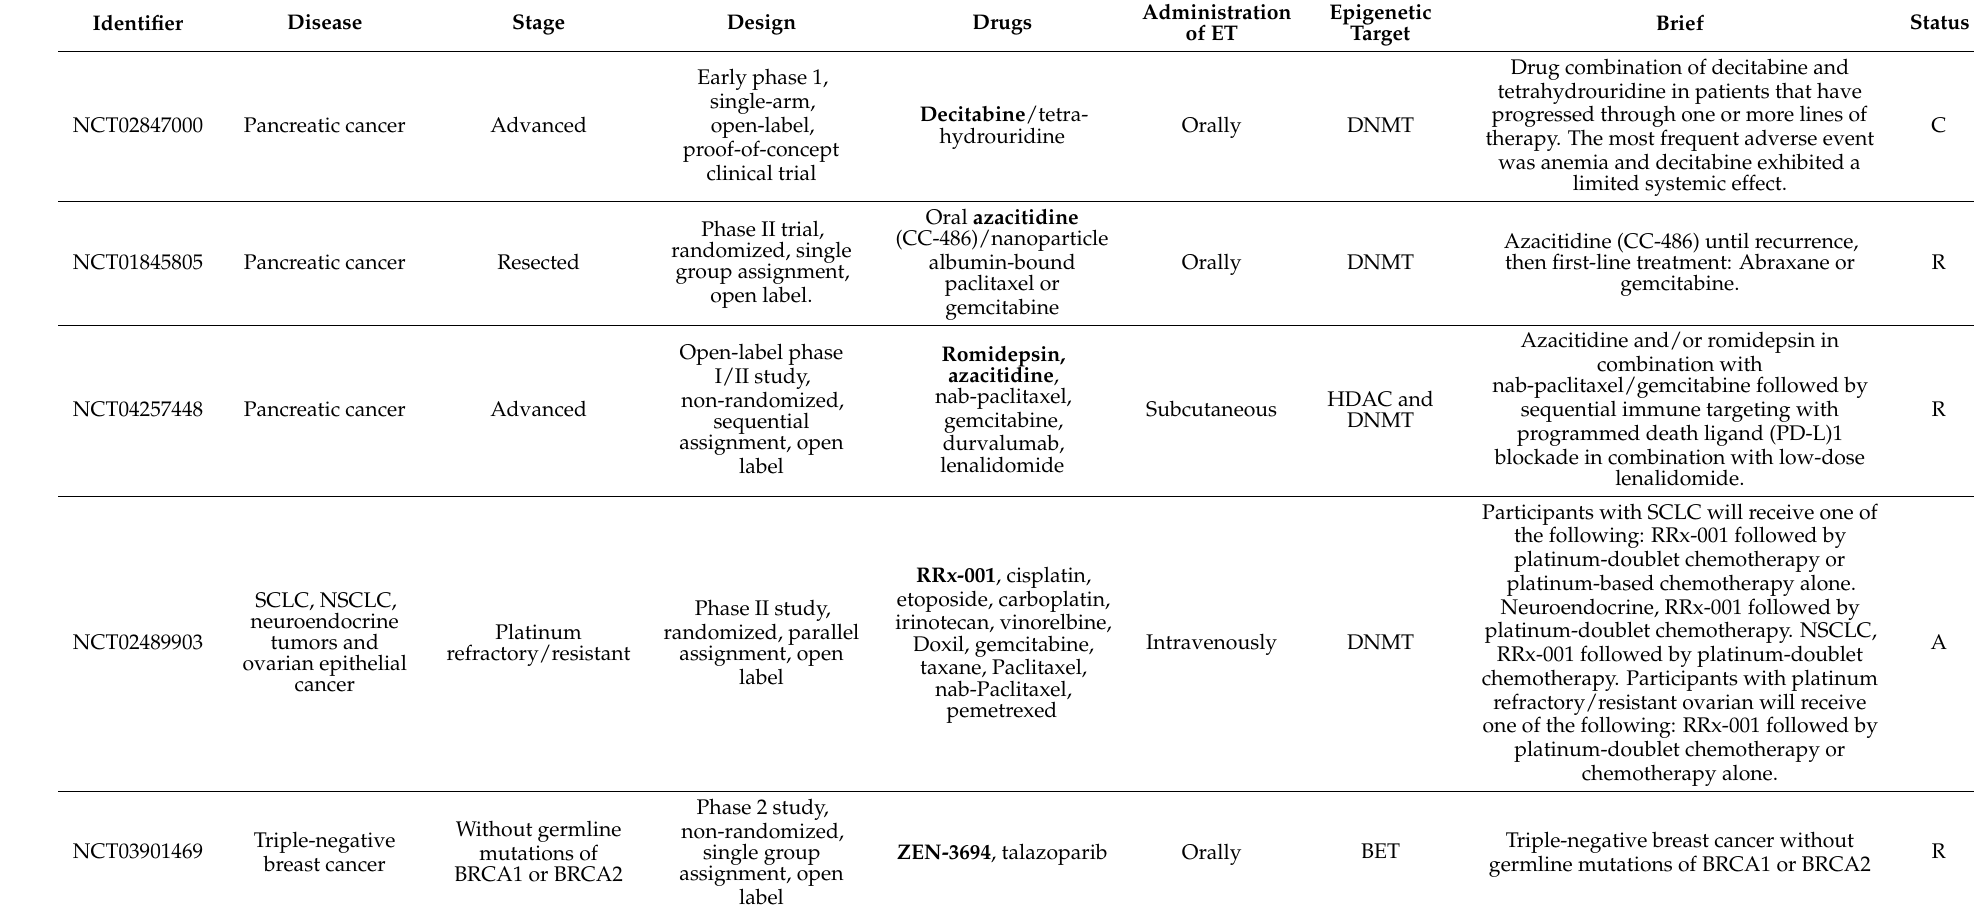
Table 1. Current clinical trials developed with epigenetic-based therapies in highly aggressive solid tumors in